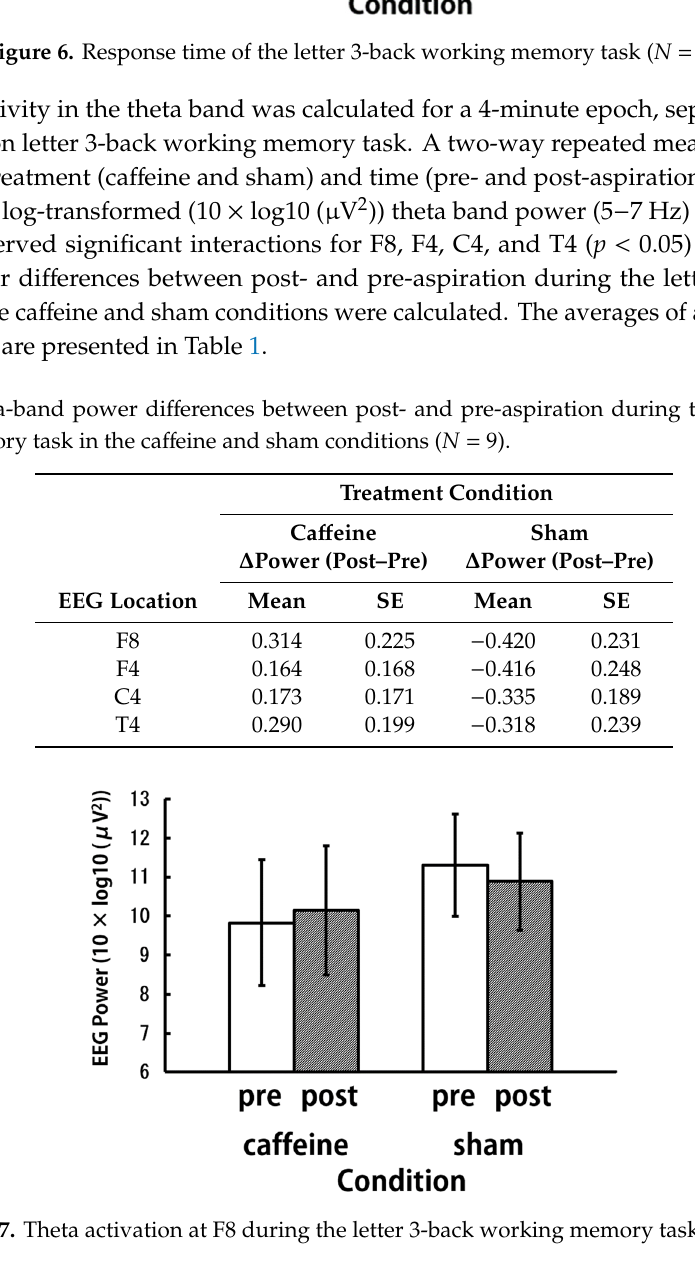
Figure 6. Response time of the letter 3-back working memory task ( N = 9).